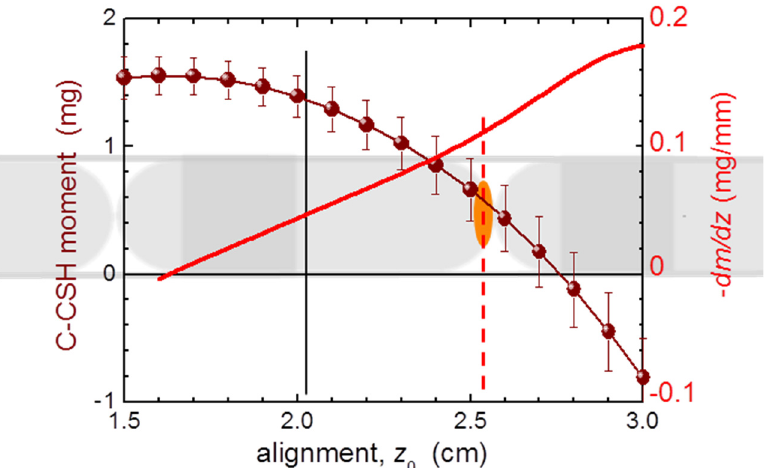
Figure 9. The position dependence of the magnetic moment (brown bullets) calculated from a scan of a fully in situ compensated train of #5 polycarbonate capsules (sketched to scale at the background) forming the capsule compensation sample holder (C-CSH) assembly. The results are related to the standard mass of a single capsule (30 mg, as in Figure 4). The magnitude of this change defines the absolute value of the misalignment error with respect to the center position (a black vertical line at z 0 = 2.0 cm). The red solid line yields the derivative of the former, that is, the magnitude of the uncertainty due to the misalignment. The orange oval mimics a small object of investigations residing at the bottom of the central capsule at the position marked by a dash red